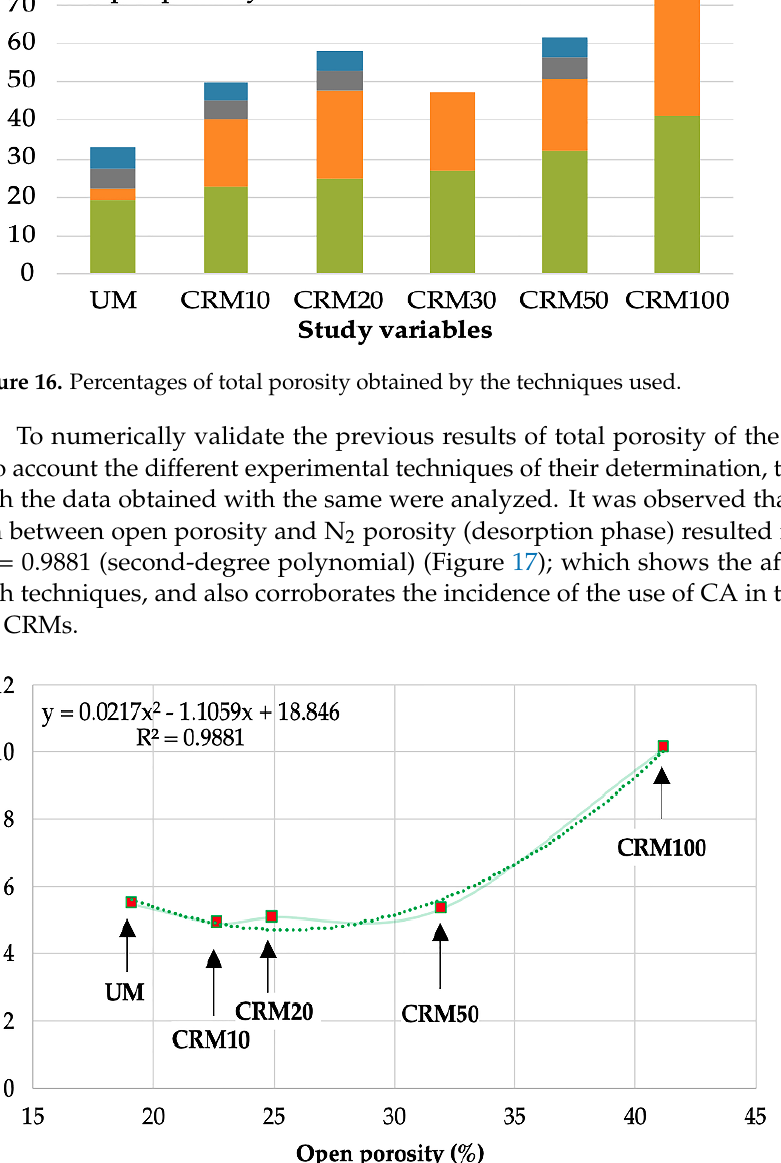
Figure 17. Correlation between open porosity and N 2 porosity (desorption phase).